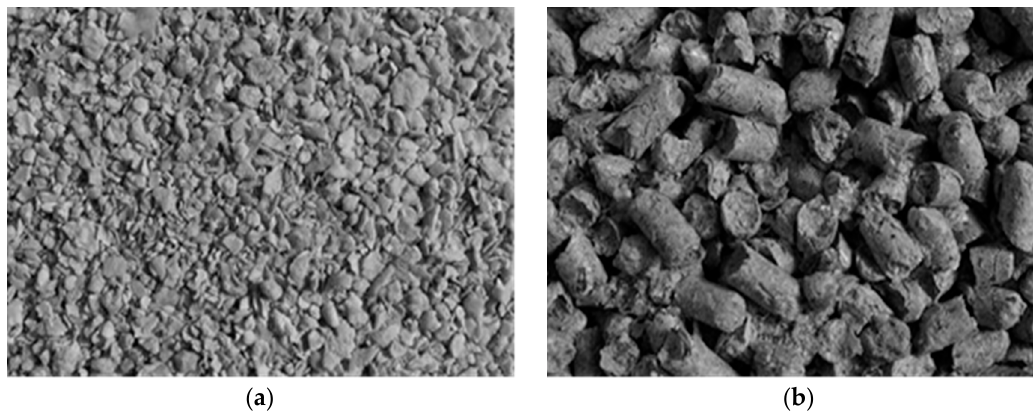
Figure 1. Photographs of representative bulk samples: ( a ) chipped soya beans; ( b ) cylindrical pelletised soya husk showing significant breakdown presumably from compaction during transportation.